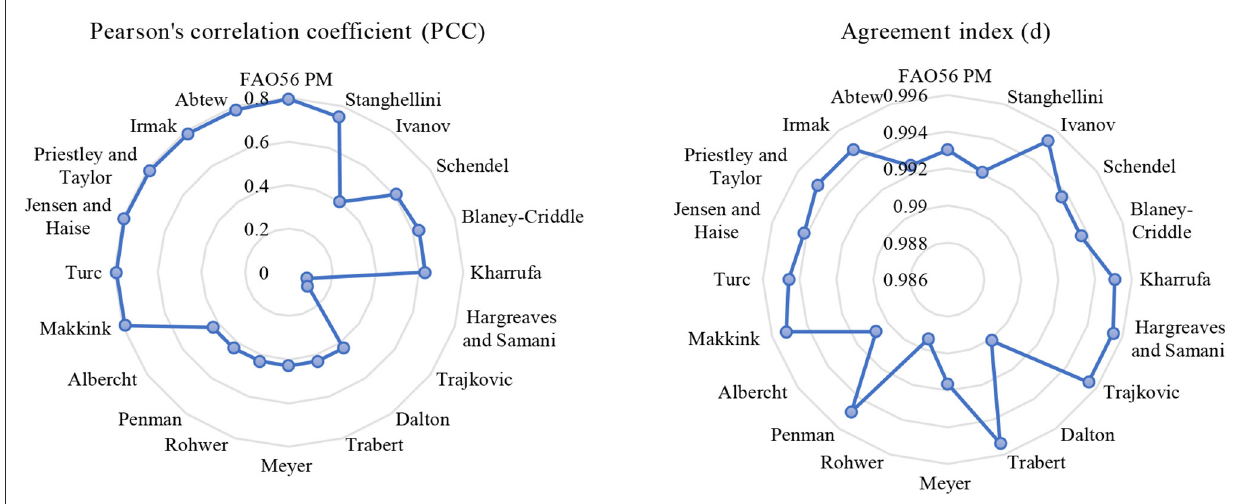
FIGURE6(Continued) Radar charts for the different statistical